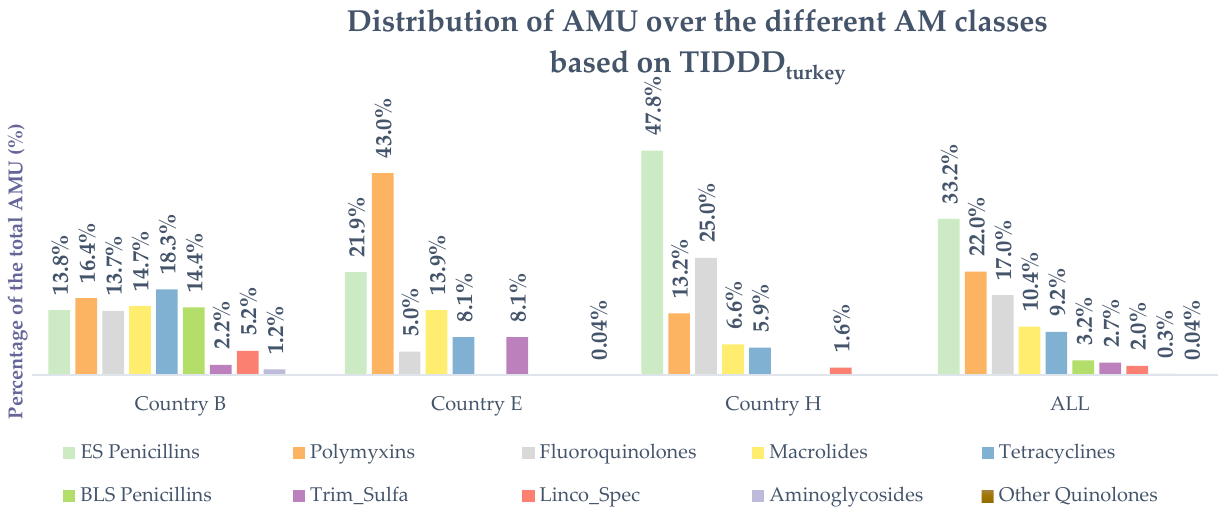
Figure 3. Distribution of antimicrobial usage (AMU) over the different antimicrobial classes, stratified per country and in total AMU is represented by treatment incidence (TI) based on DDD turkey (TIDDD turkey ). Linco_Spec = lincomycin in combination with spectinomycin. Trim_Sulfa = trimethoprim in combination with sulfonamides.